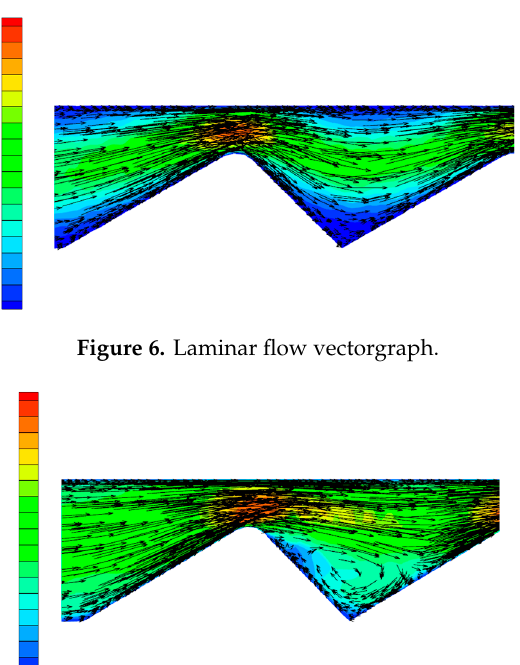
Figure 7. Turbulent flow vectorgraph.